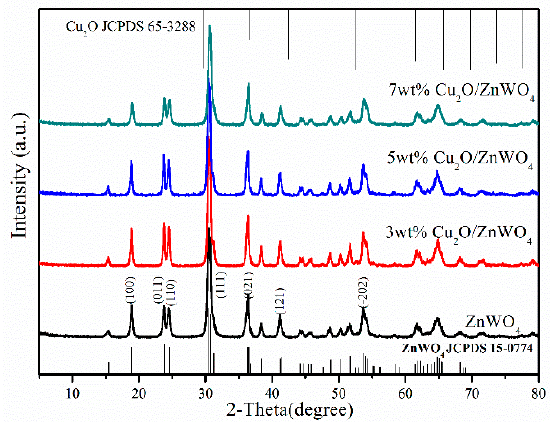
Figure 1. X-Ray Diffraction (XRD) patterns of ZnWO 4 and Cu 2 O/ZnWO 4 photocatalysts.